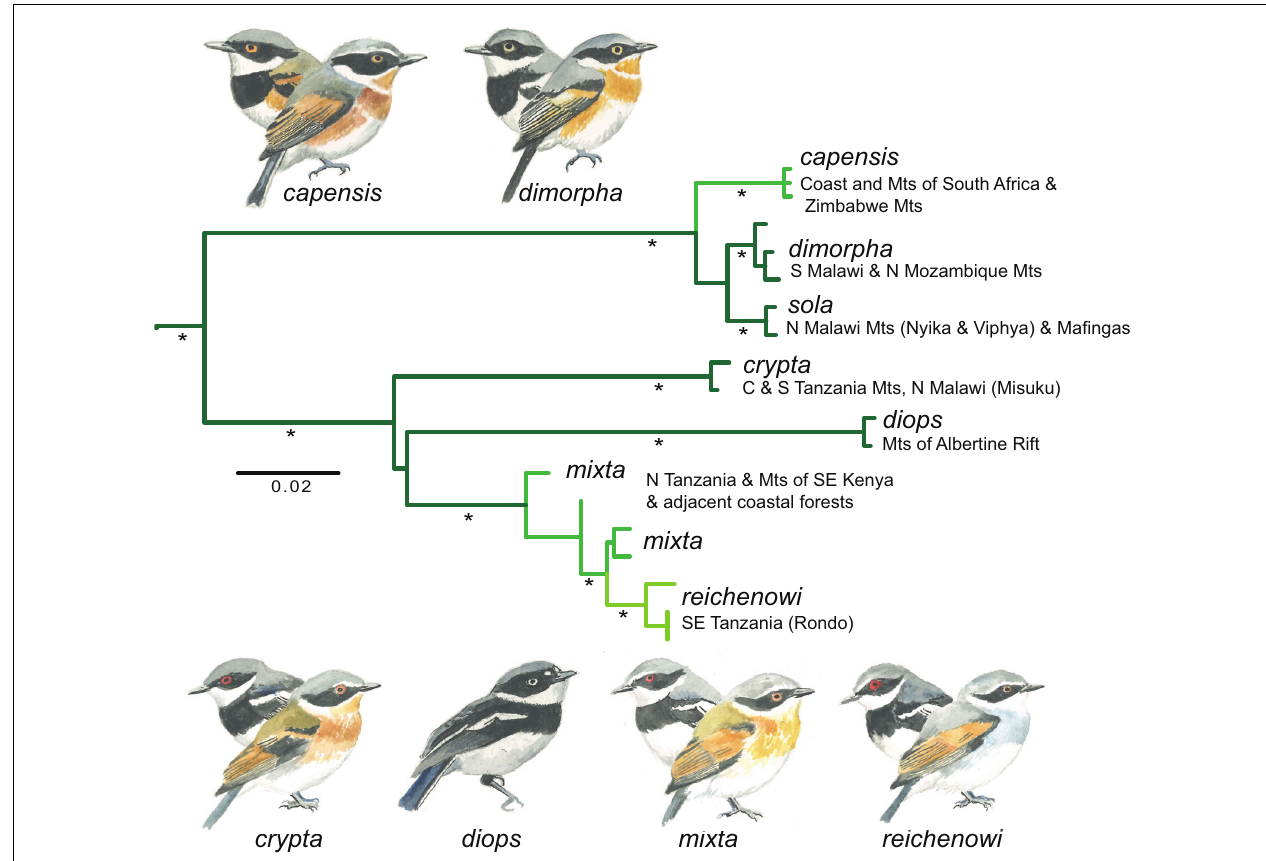
FIGURE 3 | Multilocus DNA (3 loci) phylogeny of Batis species of east and southern Africa derived from a partitioned maximum likelihood analysis. Dark green branches are indicative of lineages that occupy montane forest, light green is indicative of lowland forest, and the intermediate green color is indicative of lineages that occupy a broad elevation range extending into both lowland and montane forest. * > 75% bootstrap